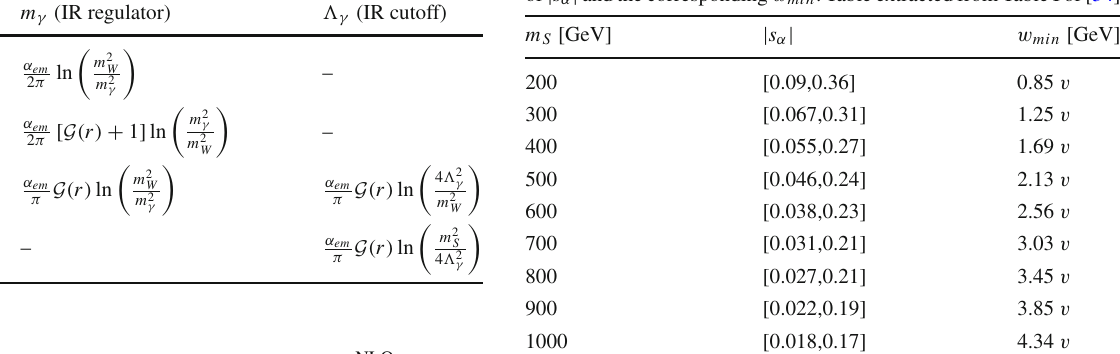
Table 3 Values of m S considered in our numerical analysis, the ranges , δ soft and δ hard W W W of | s α | and the corresponding w min . Table extracted from Table I of